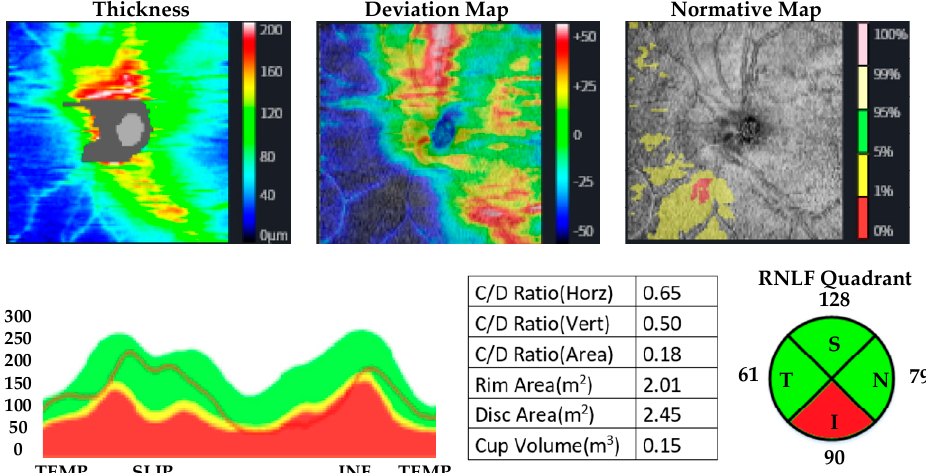
Figure 4. OCT analysis of the RNLF in a healthy participant.